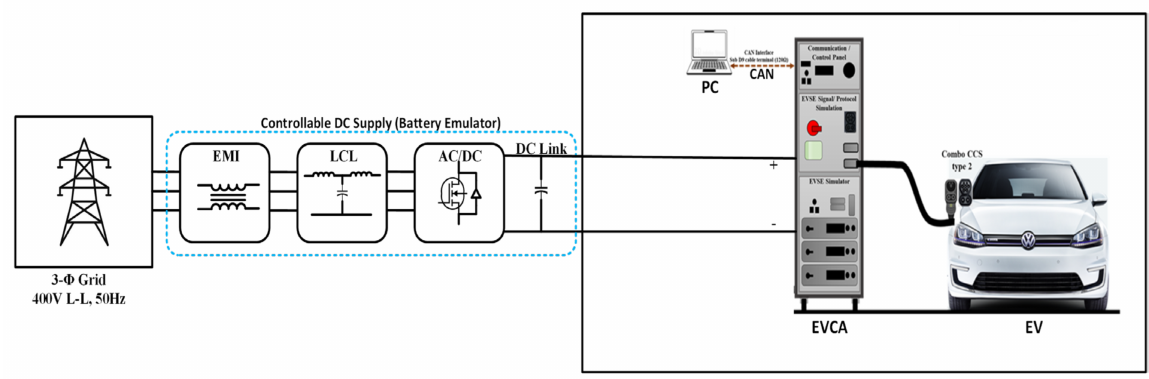
Figure 2. DC charging test system architecture with Combo CCS Type 2